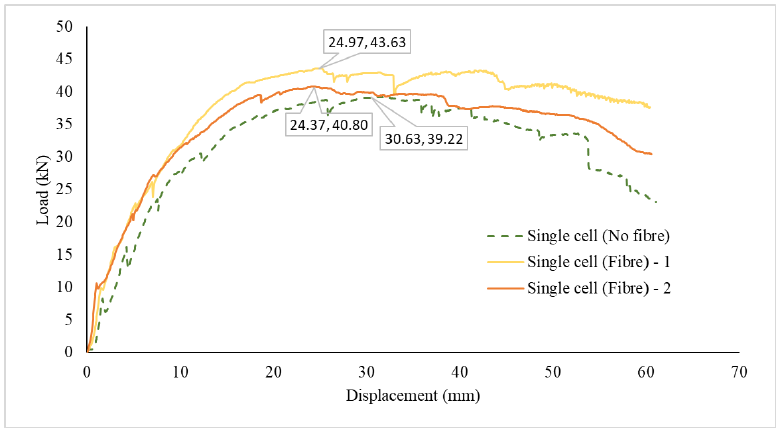
Figure 5. Load vs. displacement of single-cell infill panels.